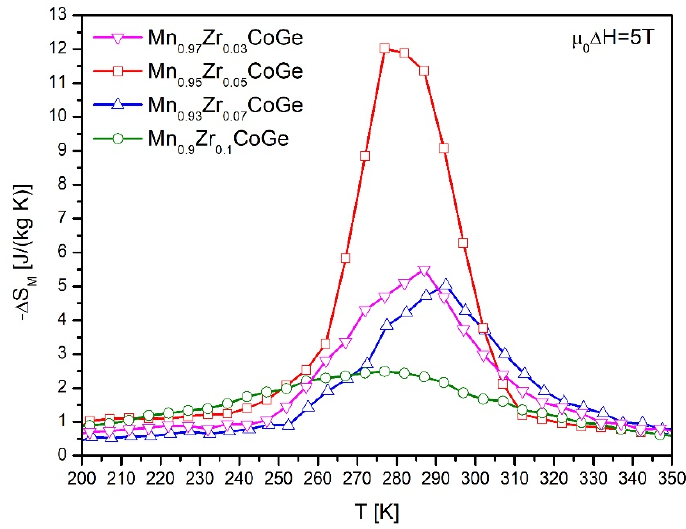
Figure 7. The temperature dependences of the magnetic entropy changes calculated for Mn 0.97 Zr 0.03 CoGe ( a ), Mn 0.95 Zr 0.05 CoGe ( b ), Mn 0.93 Zr 0.07 CoGe ( c ), and Mn 0.9 Zr 0.1 CoGe ( d ) alloys under the change of external magnetic field ~5 T. Table 2. The magnetic entropy change ∆ S M and refrigerant capacity RC for the Mn 0.97 Zr 0.03